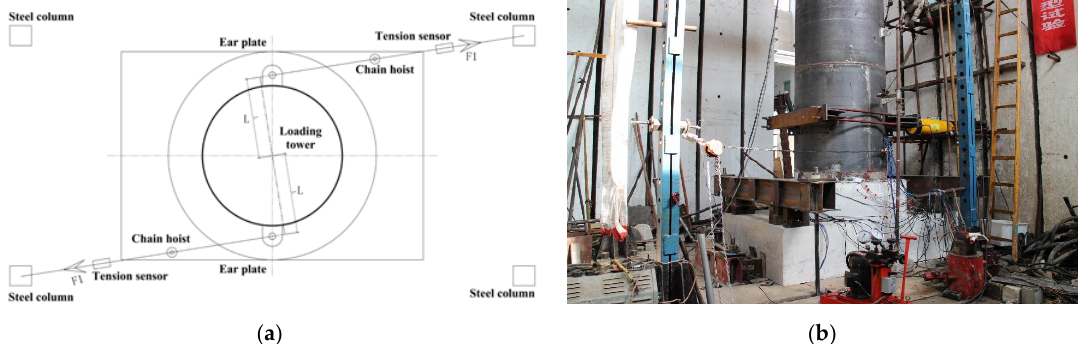
Figure 6. Loading system for indoor torque T. ( a ) Torque load loading mechanism for indoor torque T ( b ) Field loading experiment.